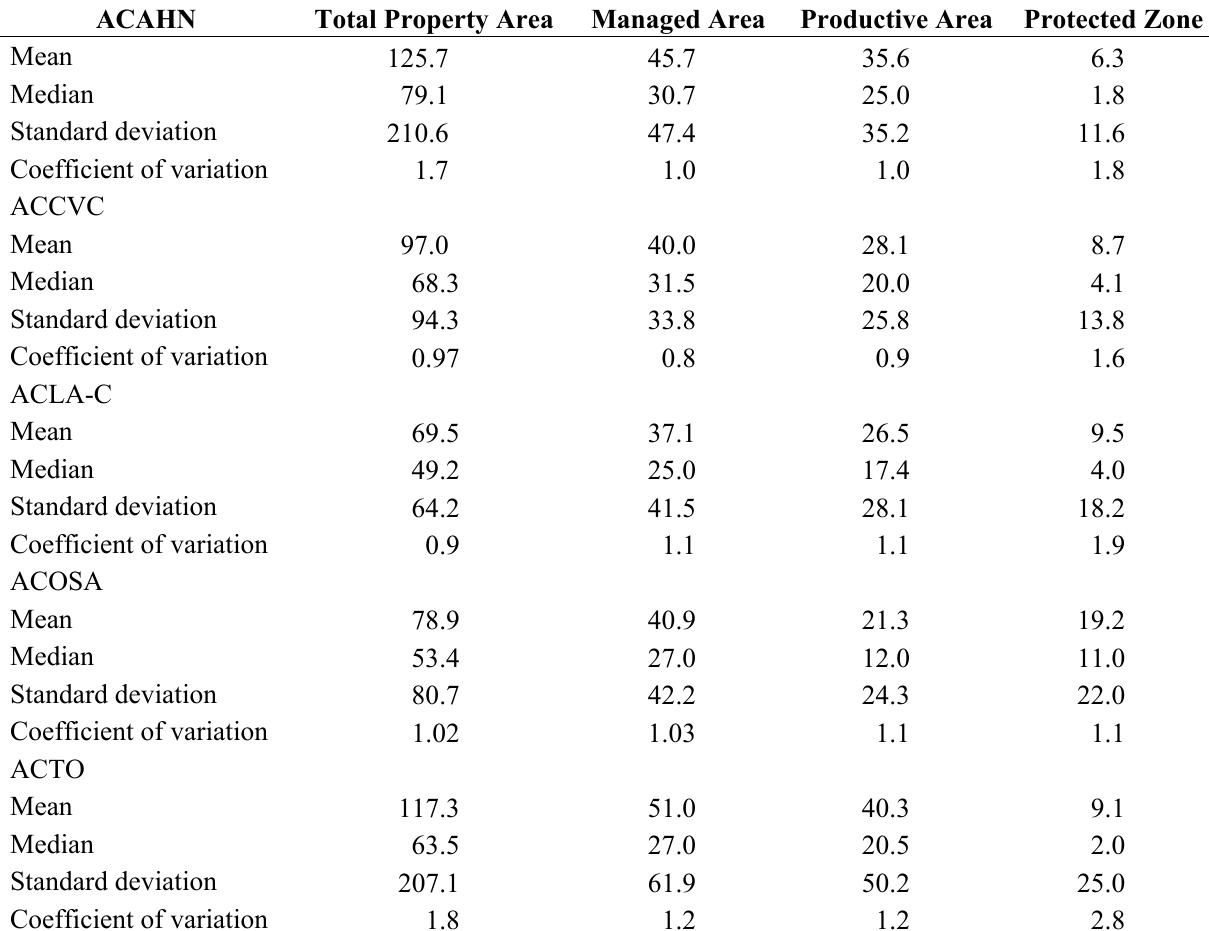
Table 1. Descriptive statistics calculated from management plans for five Conservation Areas in Costa Rica; the total property area uses the cadastral map information, while the managed area (forest stand), productive area and protected zone is defined by the Forest